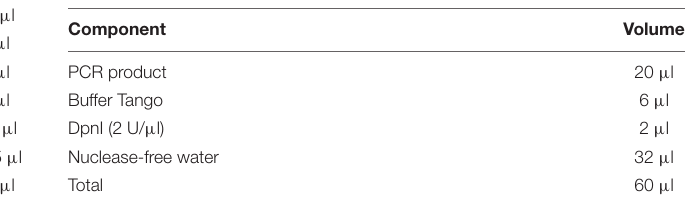
TABLE 4 | DpnI digestion reaction